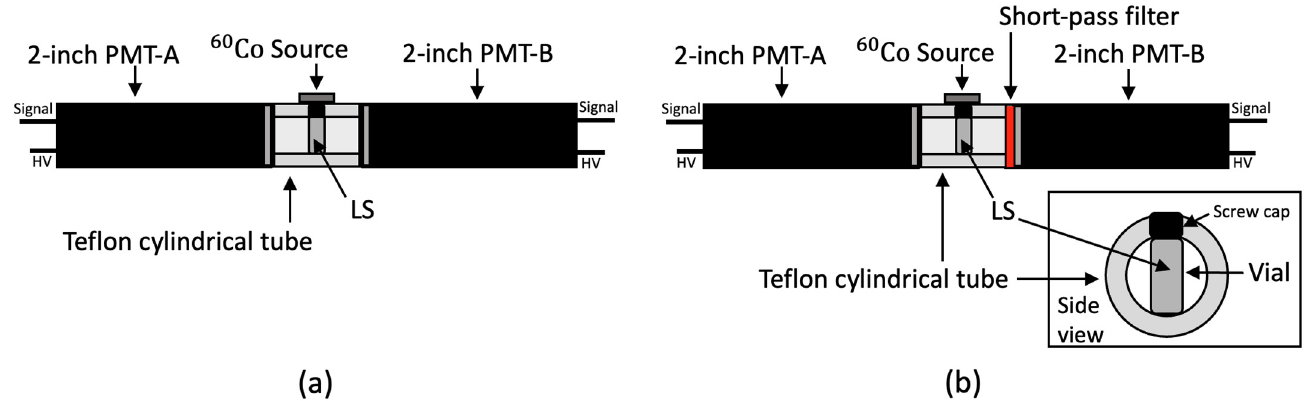
Figure 3. Schematic setup for the scintillation response measurement. The LS contained in the vial emits scintillation light via Compton scattering of the gamma-ray emitted by 60 Co: ( a ) After fixing a vial containing an LS into the PTFE coupler between the two 2-inch PMTs, the response depending on the changes in the PPO and bis-MSB concentration was measured; ( b ) Setup for measuring the phenomenon that the emission area is cut by the filter using a 425 nm short-pass filter. A short-pass filter was added to the 2-inch PMT-B only.